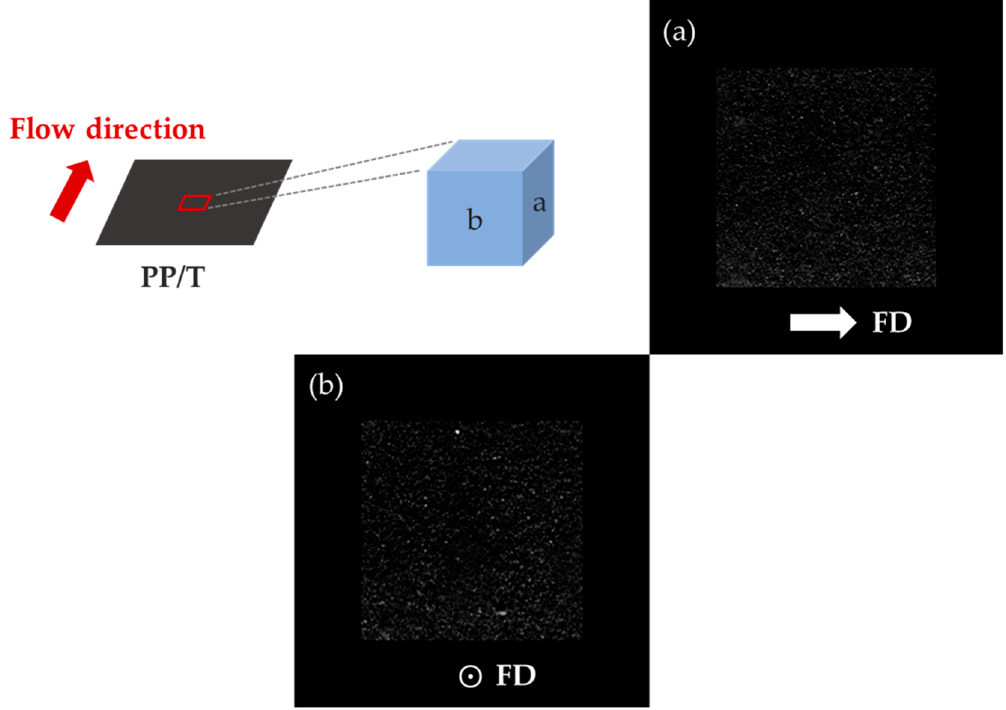
Figure 11. Distribution of talc in polypropylene (PP) measured by Micro-CT: ( a ) side and ( b ) front.